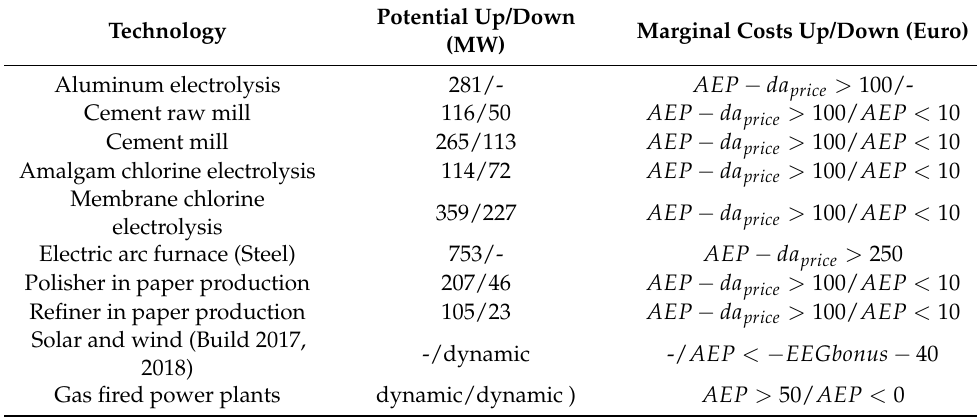
Table 5. Assumption for profit optimization parameters of BRP based on the German imbalance price (Ausgleichs-Energie-Preis (AEP)) and the day-ahead auction price for electrical energy ( da price ).